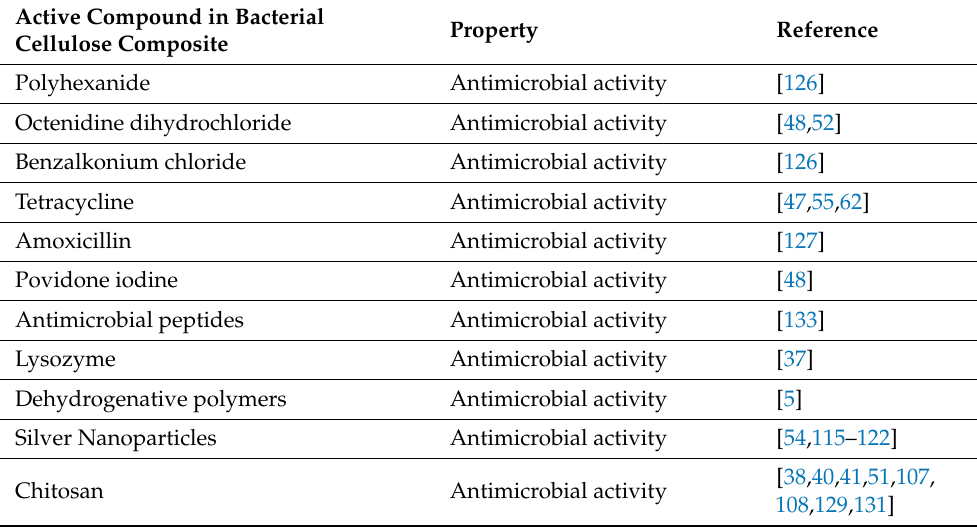
Table 3. Comparative table of bacterial cellulose composites showing the property achieved when various active compounds are